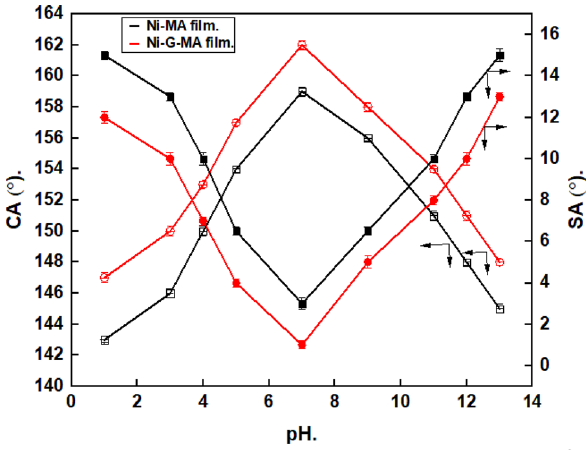
Figure 7. Variation of water droplets’ pH and their CAs and SAs on the copper coated by Ni-MA film and Ni-G-MA film.